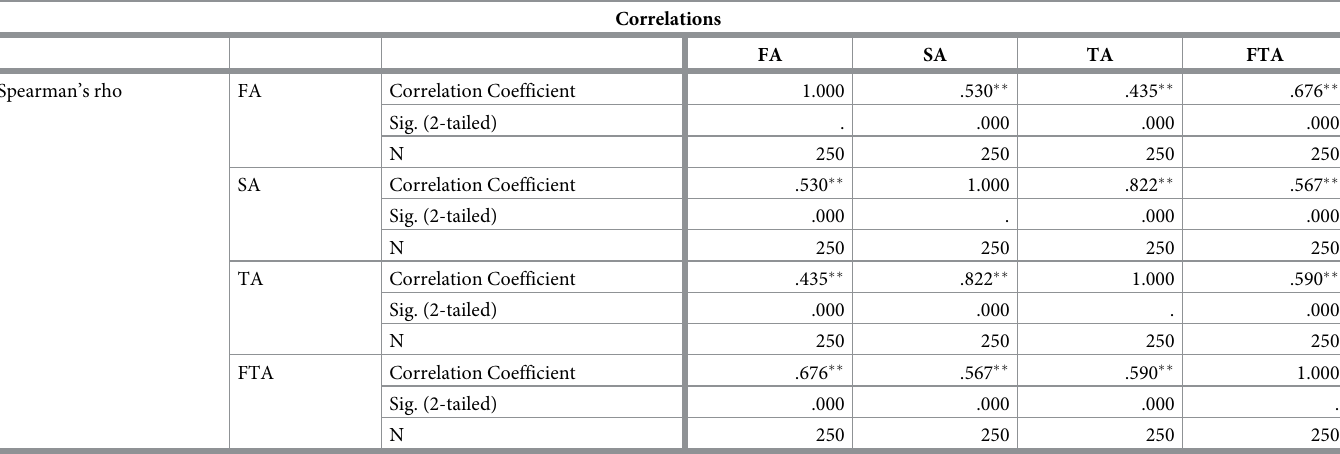
Table 3. Correlation among the four